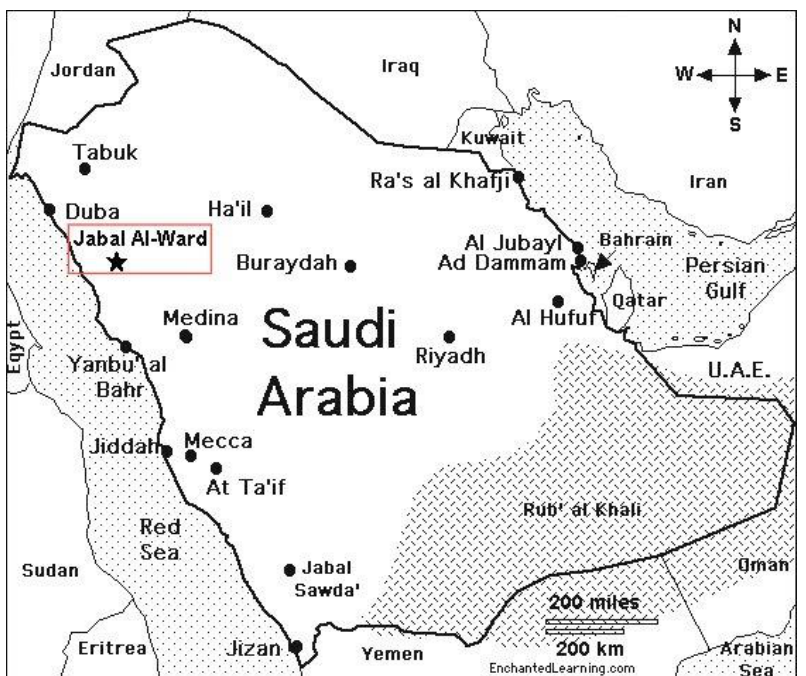
Figure 1. Map of the Kingdom of Saudi Arabia showing the study area’s location. The red rectangle refers to Jabal Al-Ward region.